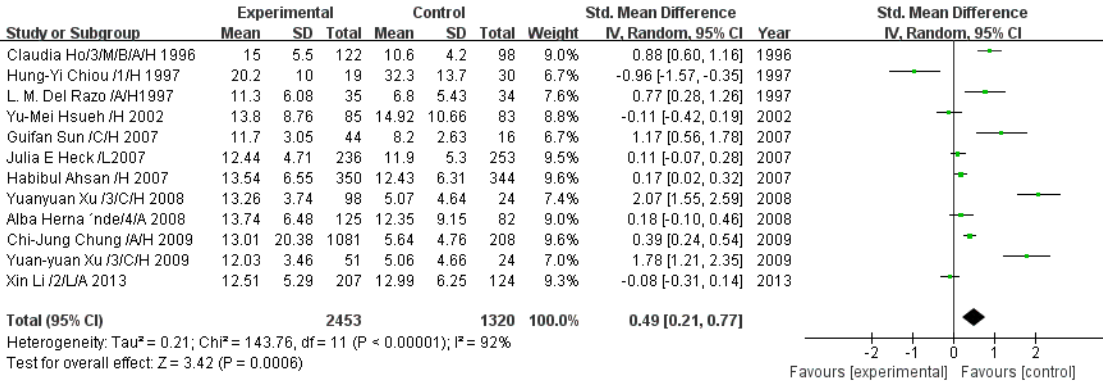
Figure 7. Effect of arsenic exposure on monomethyl arsenic percentage (MMA%) in urine. Std., standardized; SD, standard deviation; IV, independent variable; CI, confidence interval